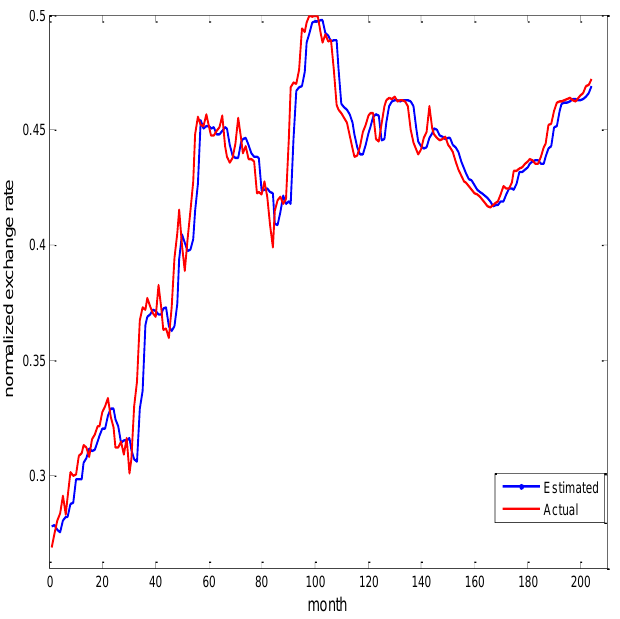
Figure 10 . Actual v/s estimated exchange rate prices for Rupees/Dollar by combined method (trimmed mean)